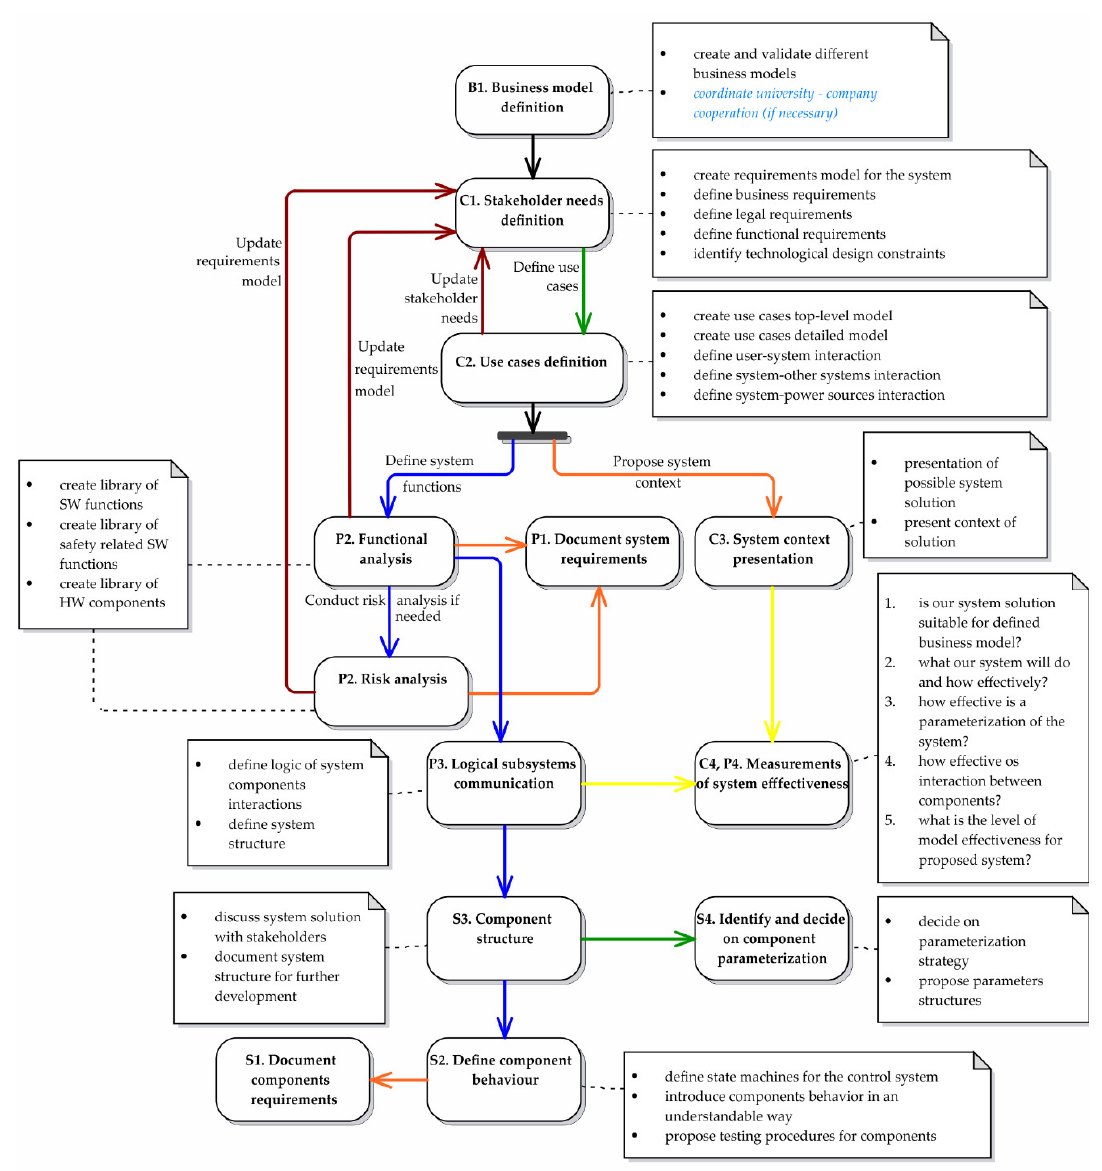
Figure 5. MagicGrid process in complex system design [33].